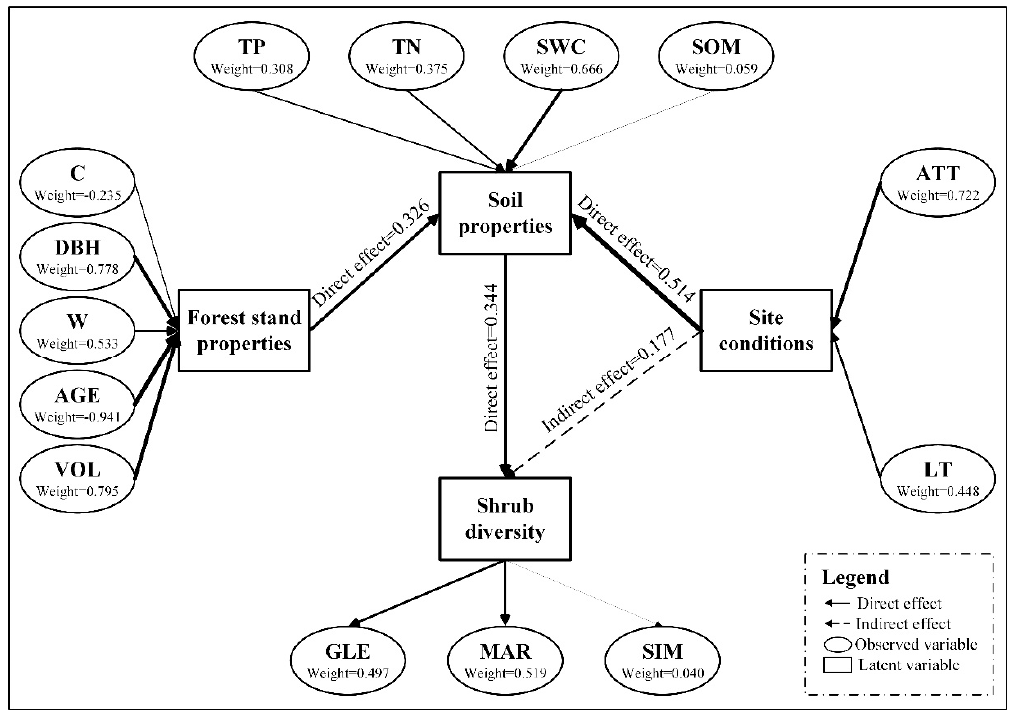
Figure 5. Final best-fit model describing the relationship of latent variables and their observed variables. The thickness of the arrow indicates the effect between latent variables or weight of observed variables to latent variables. ATT, altitude; LT, litter thickness; SOM, soil organic matter; SWC, soil water content; TN, total nitrogen content; TP, total phosphorus content; C, crowding; DBH, diameter at breast height; W, Uniform angle index; AGE, average age of the tree; VOL, forest stock volume; GLE, Gleason index; MAR, Margalef index, SIM, Simpson index.